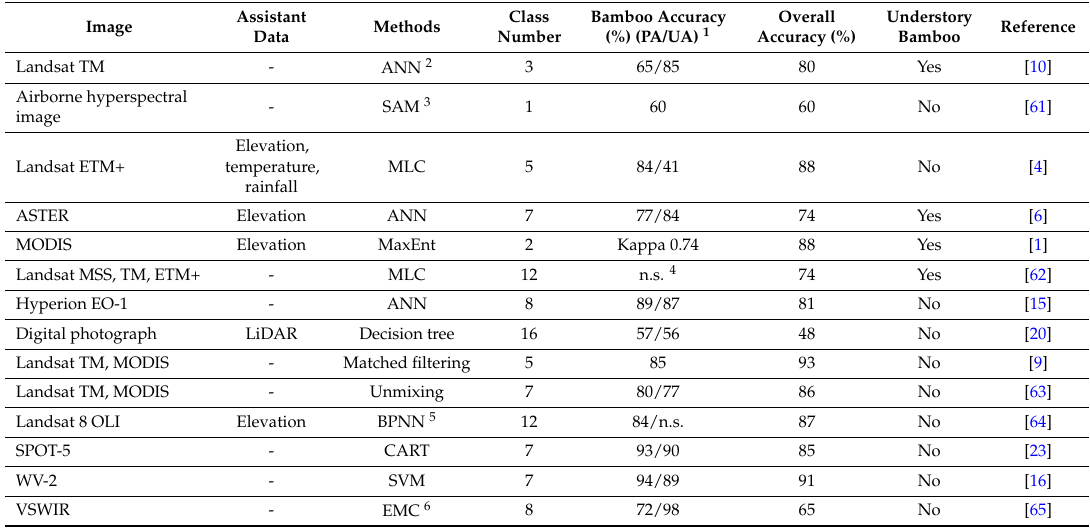
Table 6. Results from bamboo classification using different remotely-sensed images and classification methods from the last 10 years (in chronological